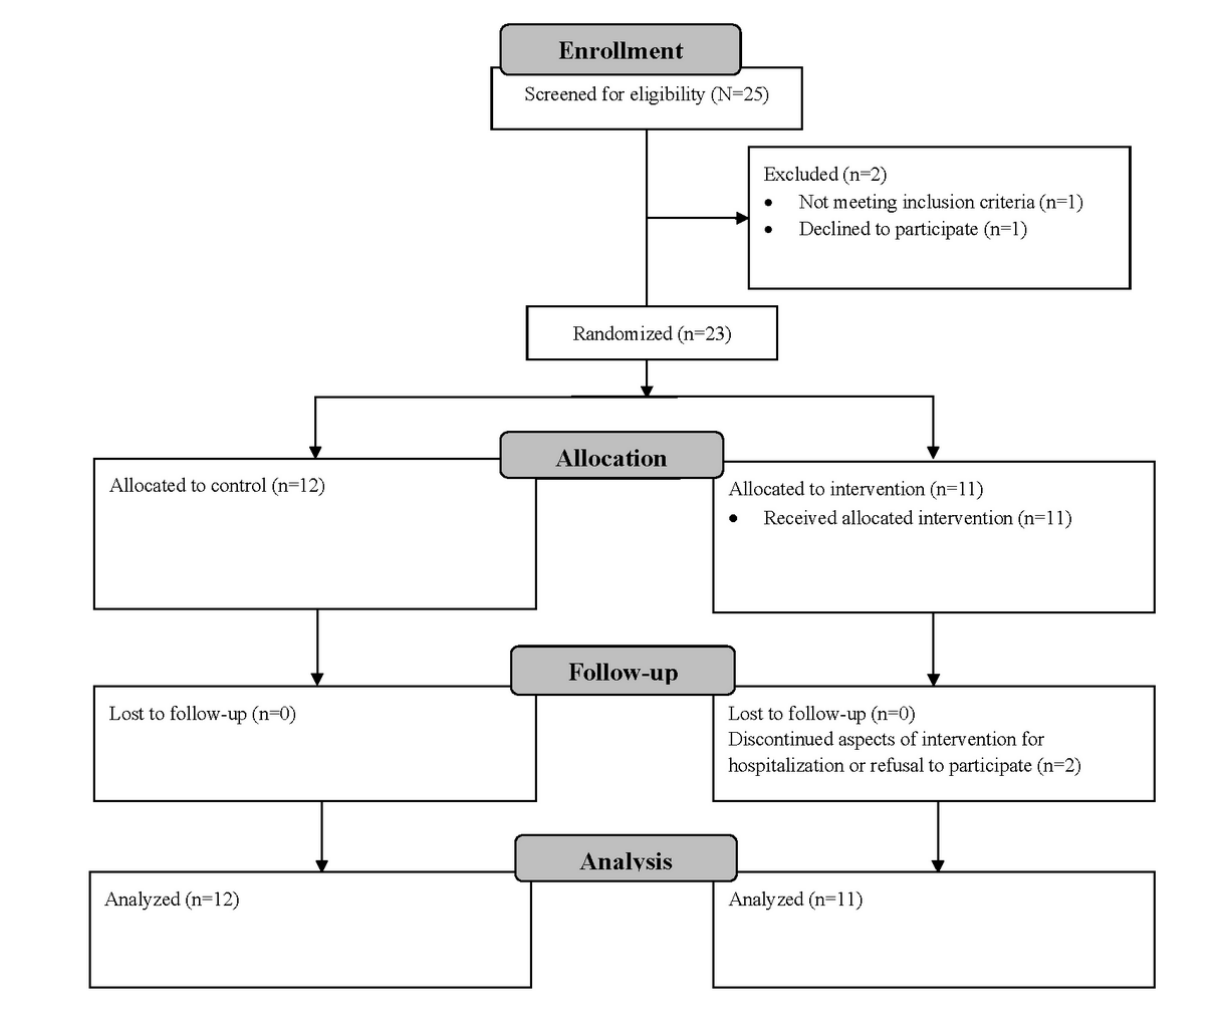
Figure 1. Study recruitment and enrollment flow